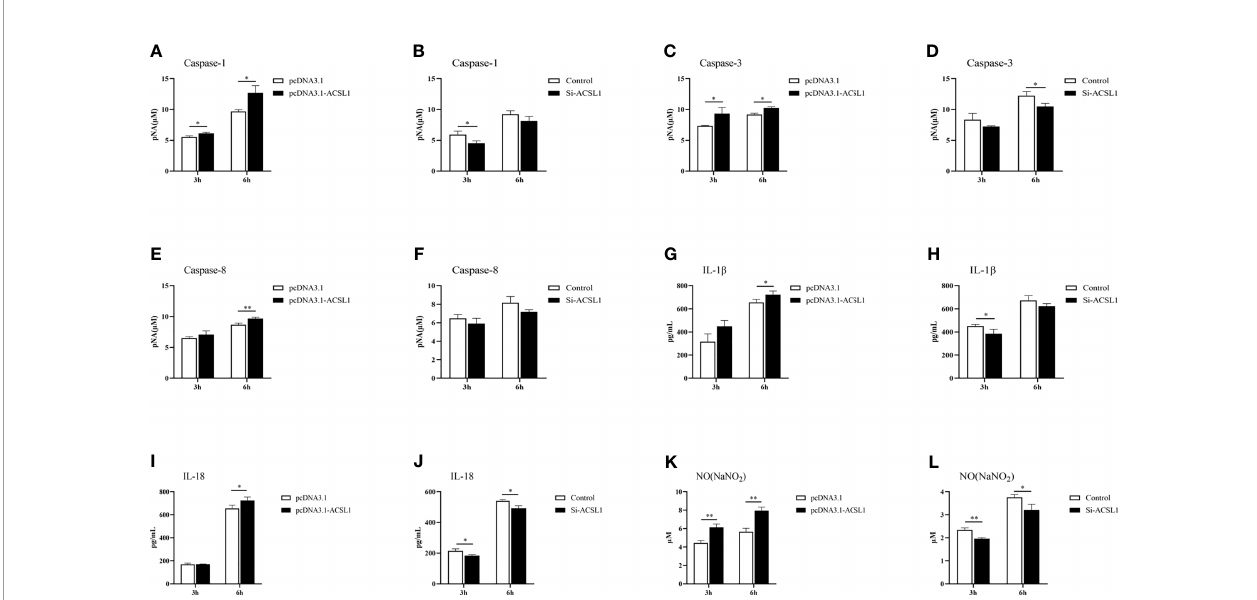
FIGURE 5 | ACSL1 promoted in fl ammation in MDMs. (A – F) Caspase-1, caspase-3, and caspase-8 activity assay kits were used to analyze caspase-1 (A, B) , caspase-3 (C, D) , and caspase-8 (E, F) enzyme activities in ACSL1 overexpressed cells or ACSL1 knockdown cells followed by ALV-J infection for 3 and 6 h. (G – J) The supernatants were harvested to examine the levels of IL-1 b (G, H) and IL-18 (I, J) by ELISA. (K, L) The supernatants were harvested to examine the concentration of NO by NO commercial kit. Data shown are the means±SEM (n=3). P values were calculated using two-tailed unpaired Student ’ s t-test. Differences with P<0.05 were considered signi fi cant. *P < 0.05, **P < 0.01.